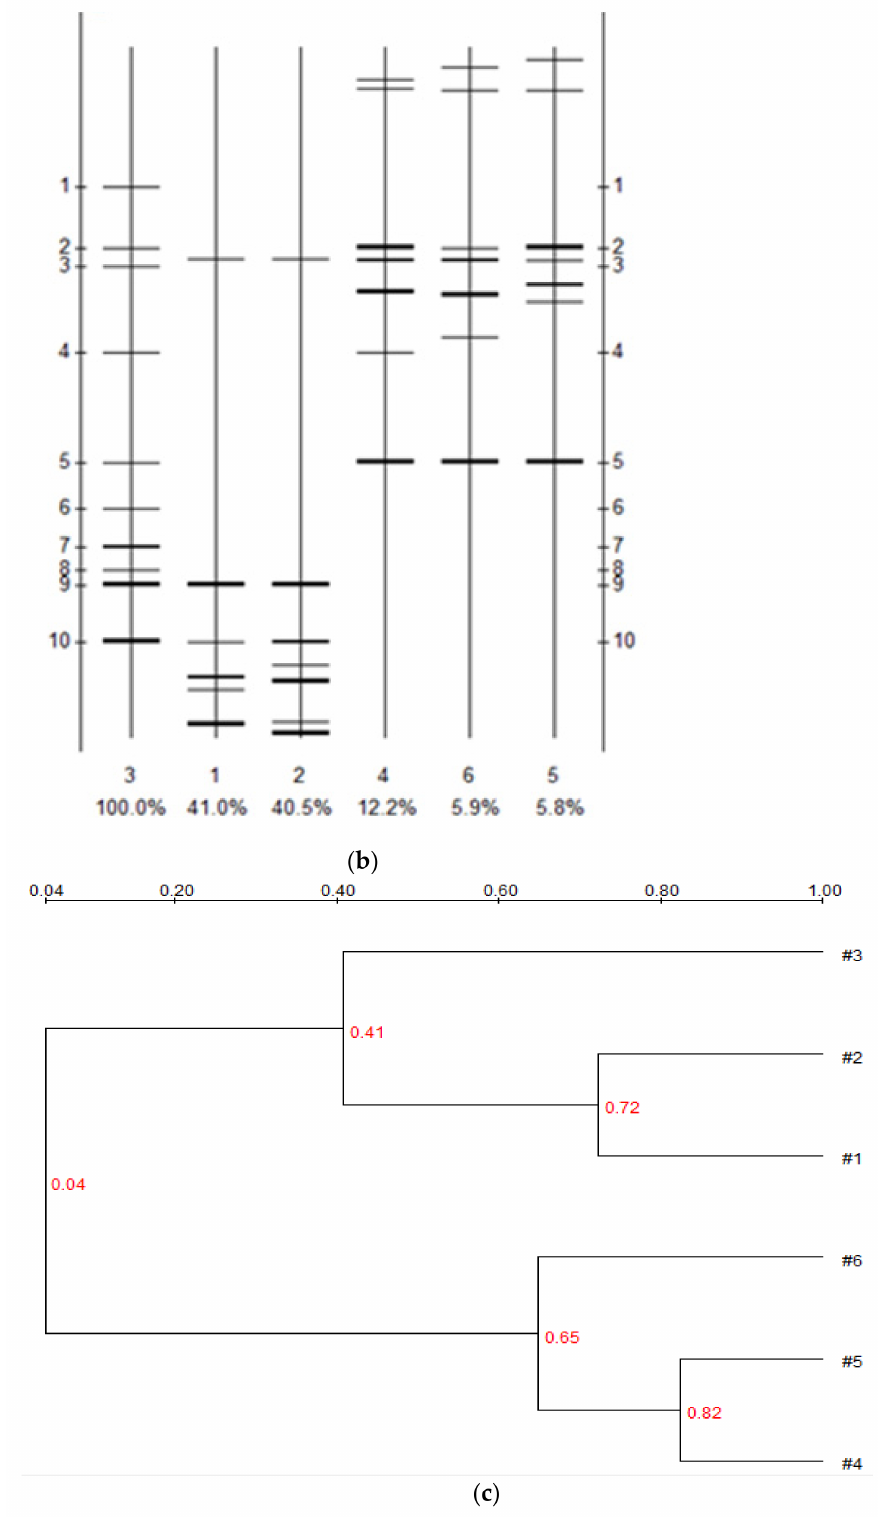
Figure 4. Fingerprint of DGGE and analyzed result in the bacterial from the soil with six treatments on the 10th day. ( a ) DNA electrophoresis fingerprint of DGGE; ( b ) diagram of compared lane images; ( c ) UPGAMA of phylogenetic tree. 10-1~10-6: S + G + D + B, S + G + D-10, S + G-10, S + D + B-10, S + D-10,